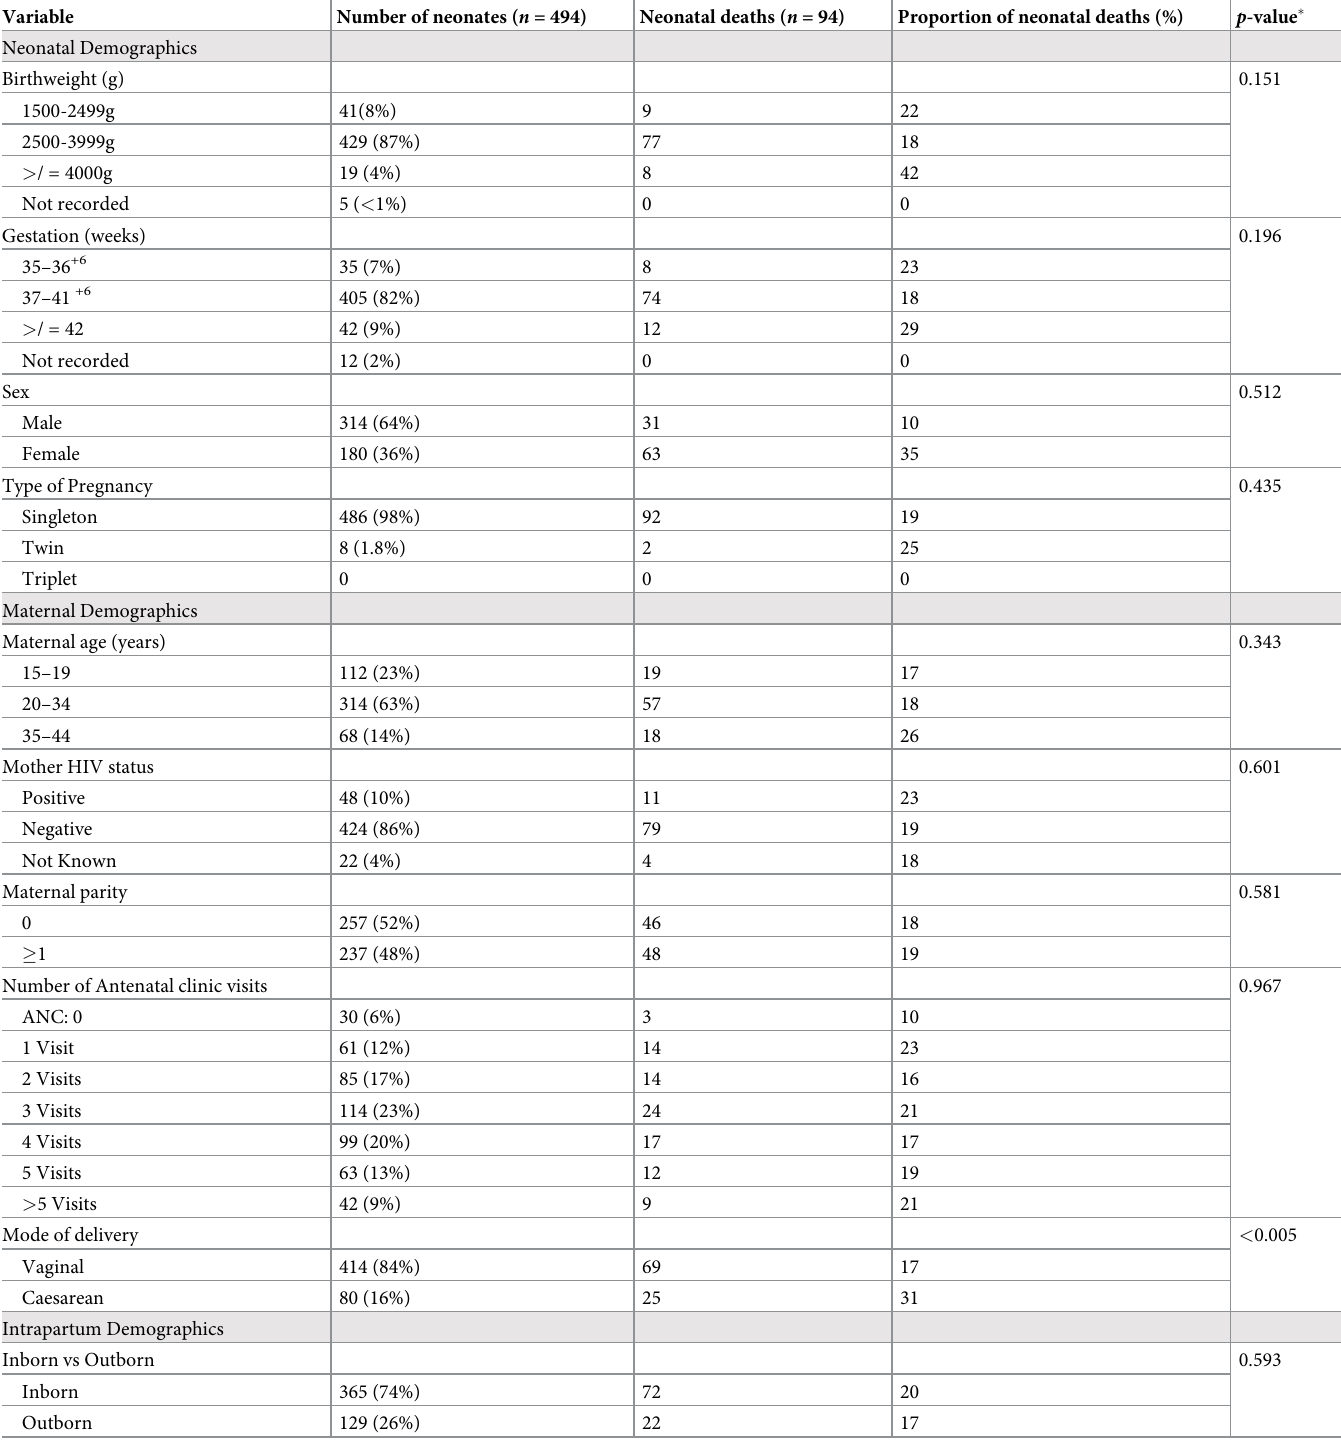
Table 1. Demographics and Risk factors associated with neonatal